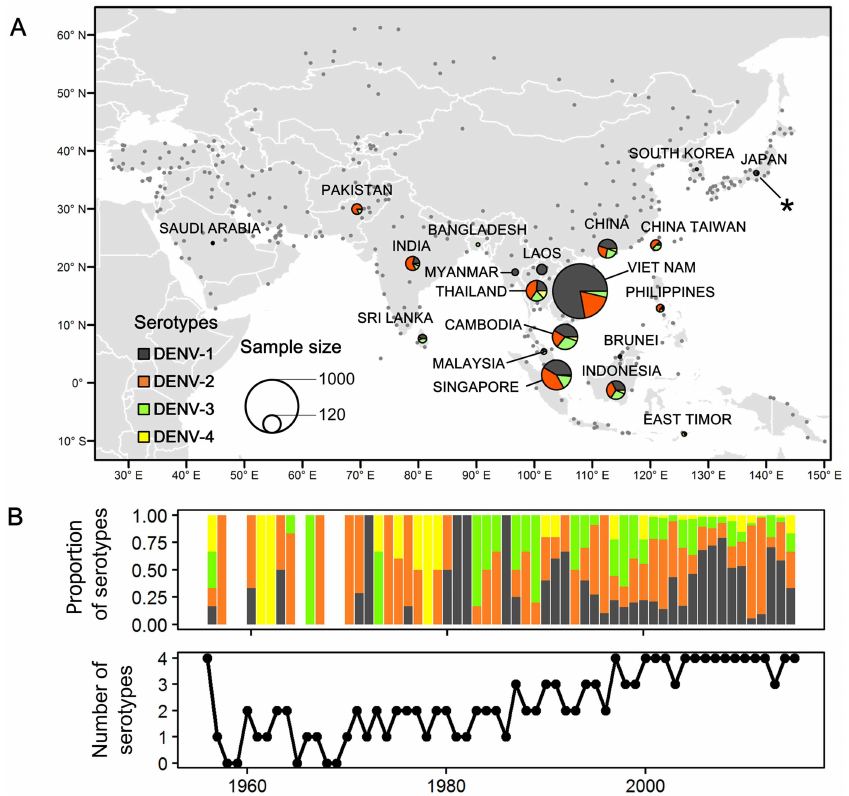
Fig 1. Co-circulation of dengue virus serotypesin Asia. (A). Locationsof availableviral sequences(within regions definedby samplingeffort) and airports. Circle areas are proportional to the number of genetic sequencesfrom a particulargeographiclocation and for a given serotype (dark grey: DENV-1, orange: DENV- 2, green: DENV-3, and yellow: DENV-4). Grey dots represent the airports for which passengerflux data was used in the analysis. Sequences obtainedfrom patients in Japan, 2014 are indicatedby asterisk. (B) The upper panel shows the proportionof sequencesfrom each serotype per year, whilethe lower panel shows the numberof serotypes isolatedper year in Asia. Co-occurrence of multiple serotypes in a singleyear has become increasingly frequent.